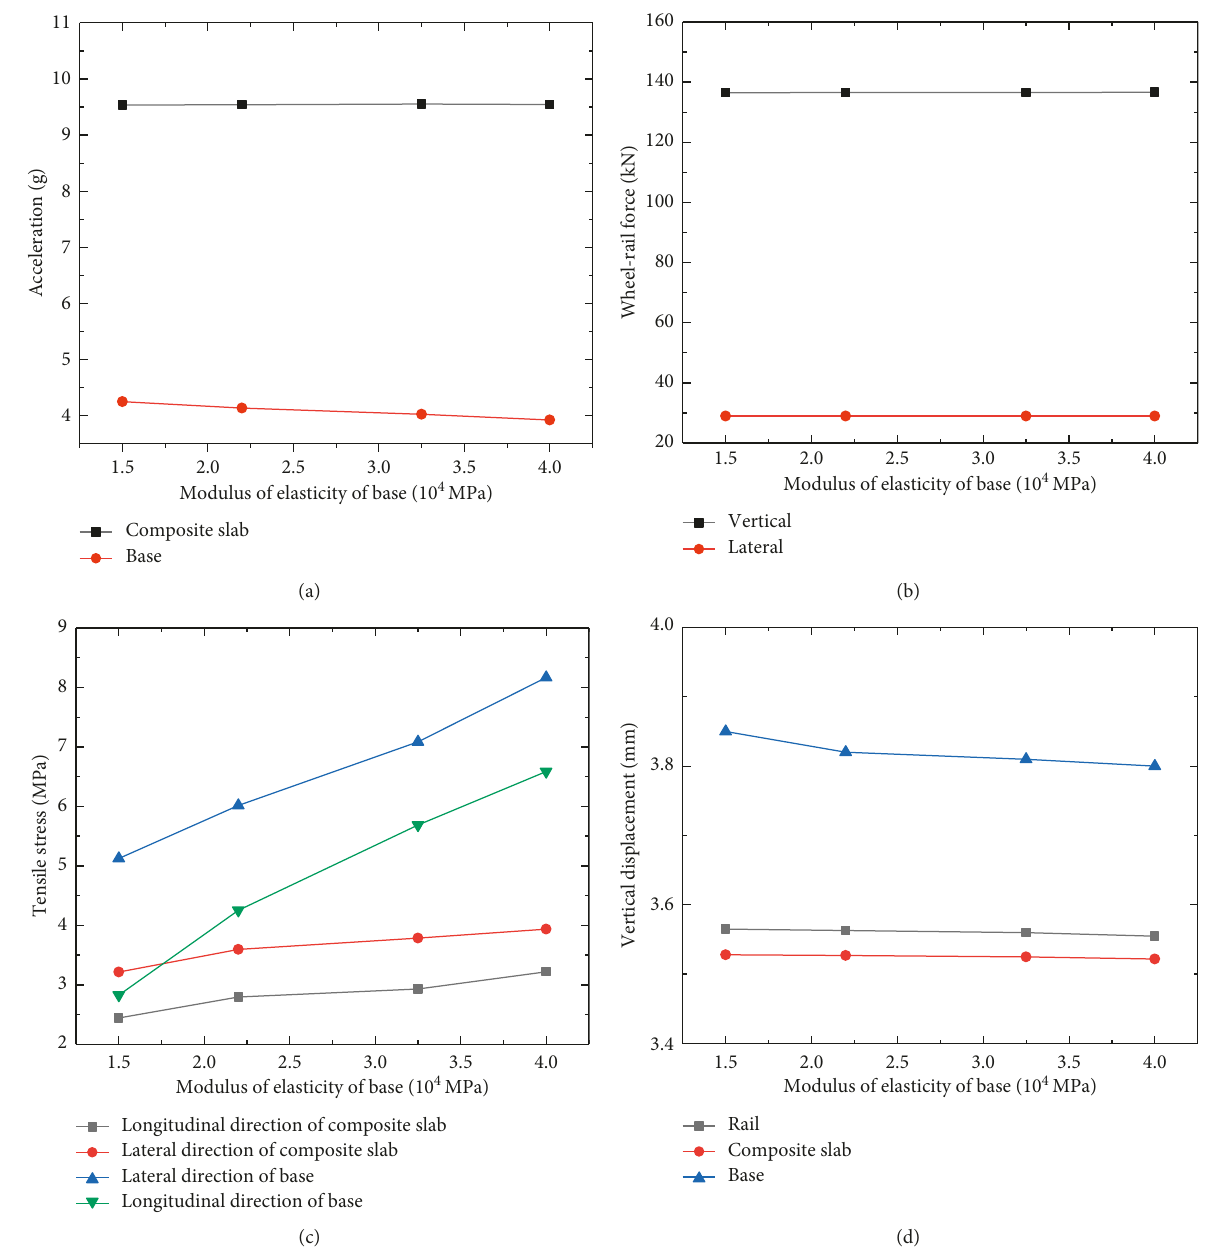
Figure 4: The maxima of the dynamic responses of the system with different moduli of elasticity of base. (a) The vertical accelerations of composite slab and base. (b) The wheel-rail force. (c) The tensile stress of composite slab and base. (d) The vertical displacement of rail, composite slab, and